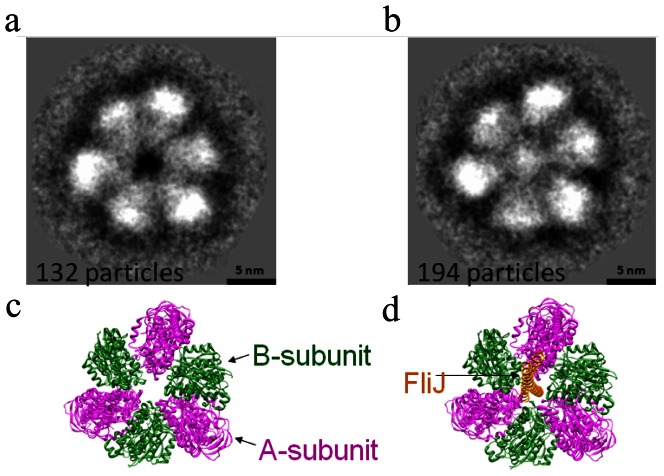
Structure of A3B3 and A3B3J.Averaged cryo-EM image of A3B3 (a) and A3B3J (b) are shown. Possible ribbon models of A3B3 (c) and A3B3J (d) are also indicated below each EM image.